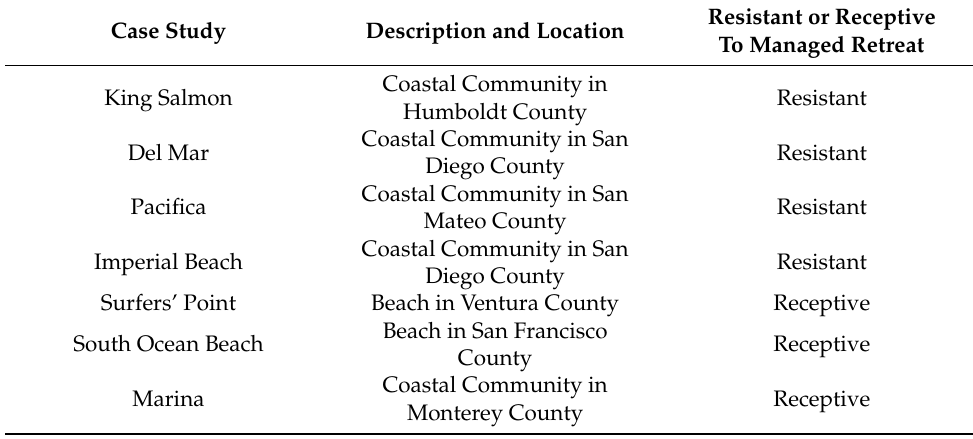
Table 1. Description and categorization of selected case studies in California. Case